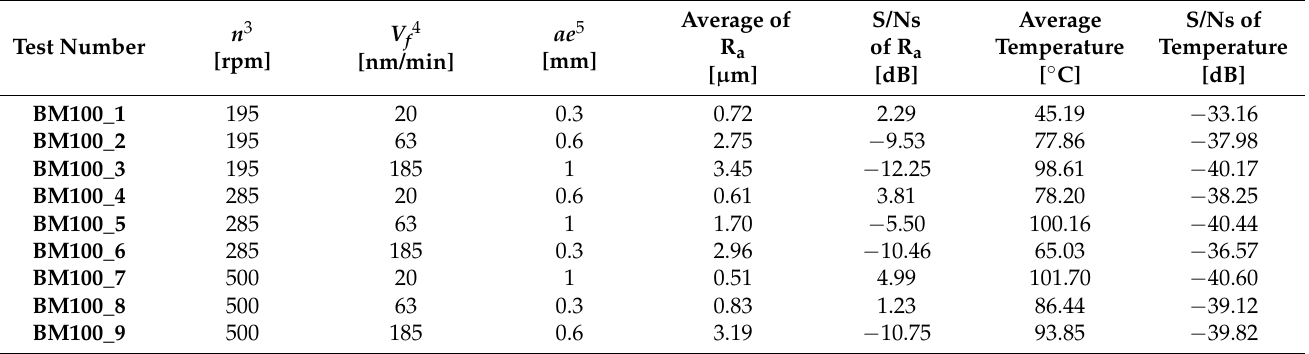
Table 8. Average surface roughness, average chip temperatures, and S/Ns ratio with Balis Mafcool 51 (100 mL/h).